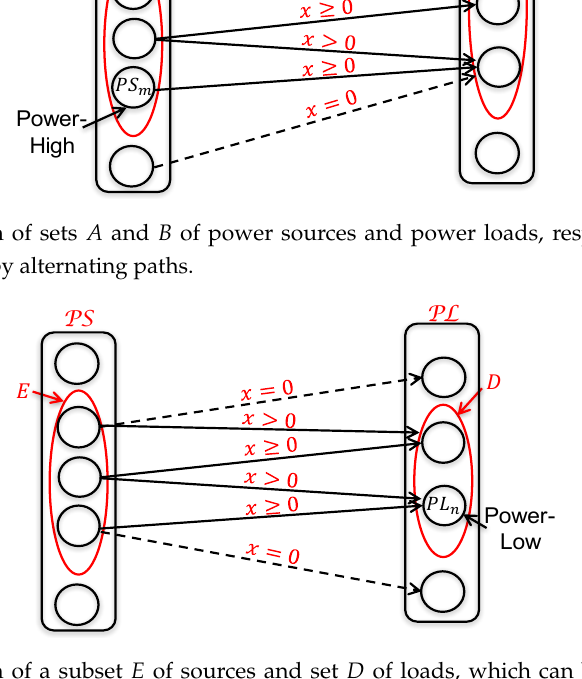
Figure 9. Illustration of a subset E of sources and set D of loads, which can be starting nodes of alternating paths terminating at PL n